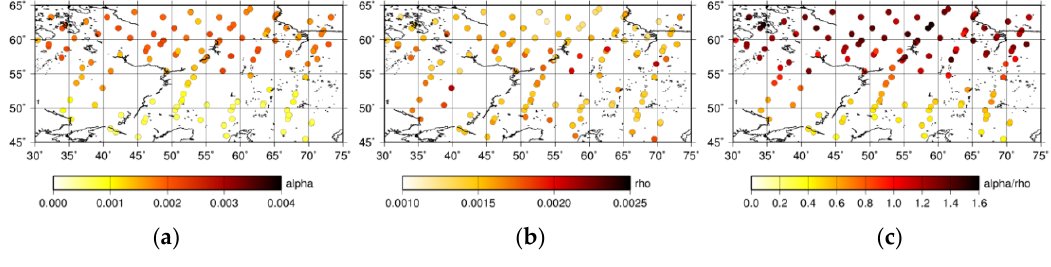
Figure 11. Distribution of the retrieved PPDF parameters: α a ( a ), ρ a ( b ), and α a /ρ a ( c ).